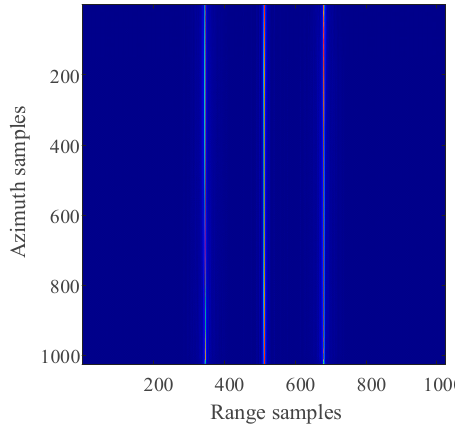
Figure 12. The result of using the algorithm proposed in this paper to restore the missing data (time domain).